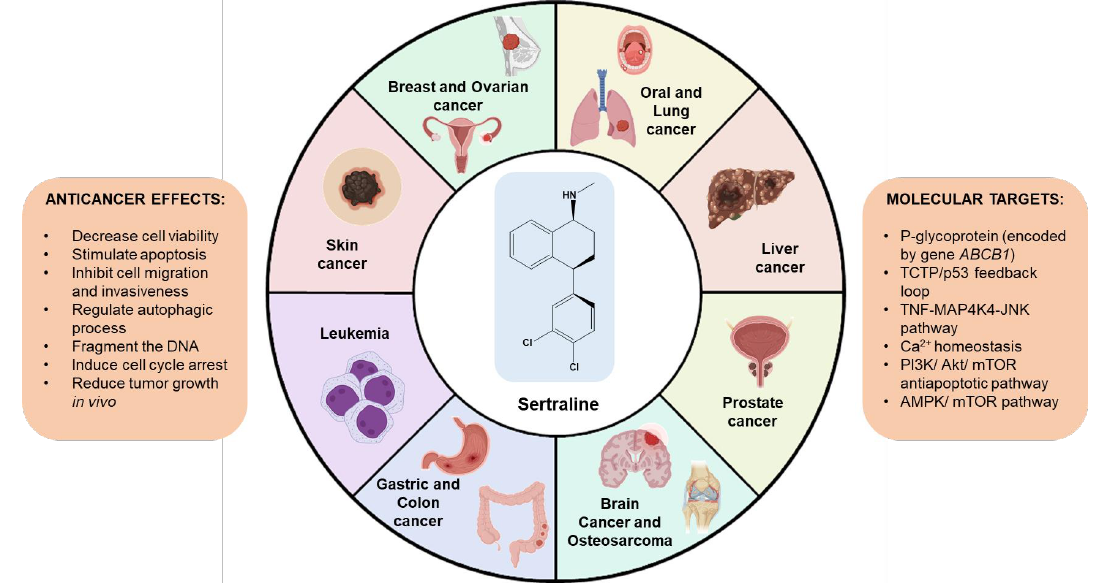
Figure 3. Overview of this review and main findings on the research of sertraline in cancer.